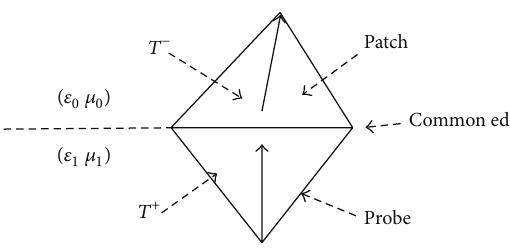
Figure 5: The triangle pair at the junction.